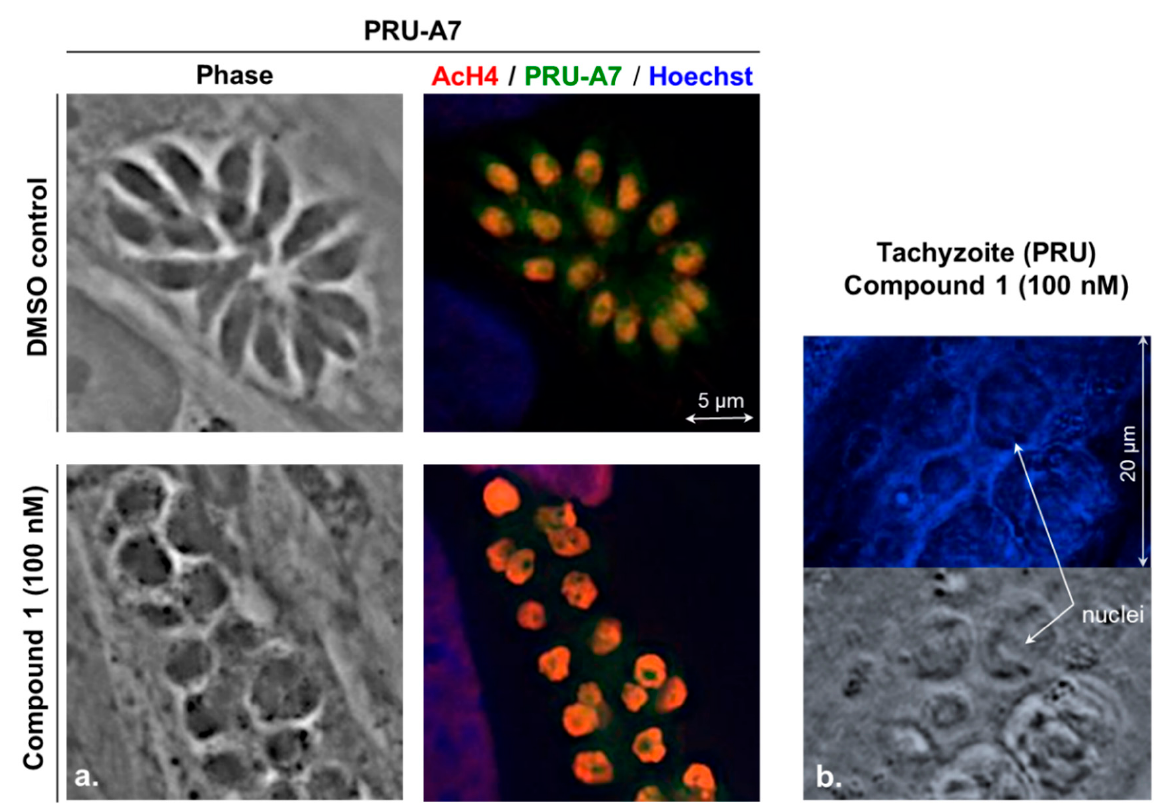
Figure 5. ( a ) In vitro tachyzoites PRU- ∆ hxgprt-A7 strain (PRU-A7) treated with the compound 1 results in an increased level of histone-H4 acetylation (AcH4) associated with dysmorphic features (increased size, giant polynucleated parasites, rounded shape); Fixed cells, AcH4 in red (anti-acetyl-H4 polyclonal rabbit antibodies (primary antibodies) (Millipore), followed by the secondary antibodies goat anti-rabbit IgG coupled with either Alexa Fluor 568 (Invitrogen) at a 1:1000 dilution), tachyzoite GFP protein (PRU-A7 in green)), HFF, and tachyzoite DNA in blue (Hoechst) ( b ) Localization of the compound 1 in treated PRU tachyzoites observed by microscopy (c = 100 nM, 48 h, exposure time 1000 ms).